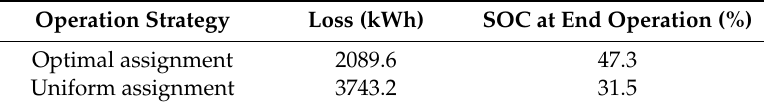
Table 2. Loss comparison between uniformly and optimally assigned power operations.